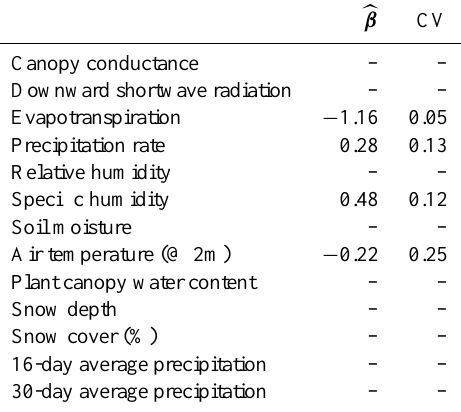
Fig. 3. (a, b) Optimized covariance parameters using the RML algo- rithm with the atmospheric measurements, for the GIM inversions with the EMP boundary conditions. (a) Monthly flux standard devi- ations ( σ Q ) for the Simple and NARR inversions. (b) Square root of the yearly average model-data mismatch variances ( σ R ) (weighted by the number of data-points in each month) for 9 towers, flask and aircraft data from the Simple inversion. Location information for each measurement code is included in Table A1 in the